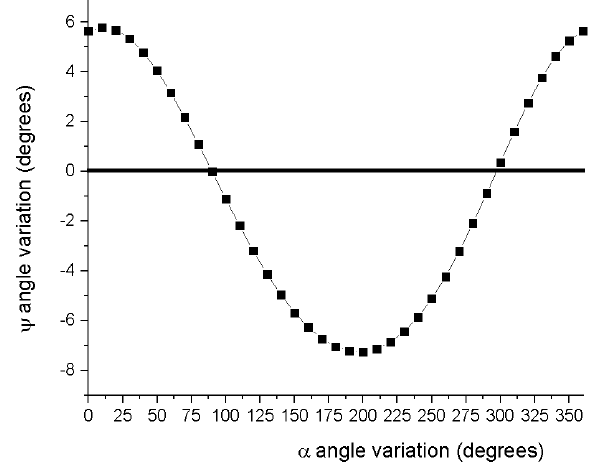
Figure 8. Variation of the angle ψ depends on the variation of the angle of the crank α . The analysis of the graphical representation (Figure 8) shows that the values of the angle ψ are grouped into positive and negative values. These values correspond to the position of the tie rod about the vertical, respectively (Figure 4), where: o Positive values correspond to the position on the left side of the vertical; o Negative values correspond to the position on the right side of the vertical. The graphical representation of the angle variation was generated according to the variation of the crank angle α , so the time variation of this angle, the value described by the free end of the tie rod, for a complete crank cycle is the sum of the two maximum angle values for the two